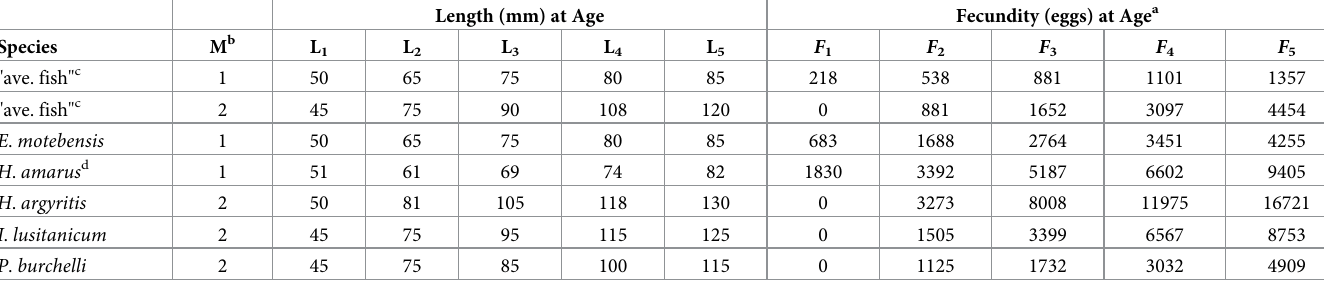
Table 2. Age of maturity and values of length and fecundity used in simulations of age truncation. Length (mm) at